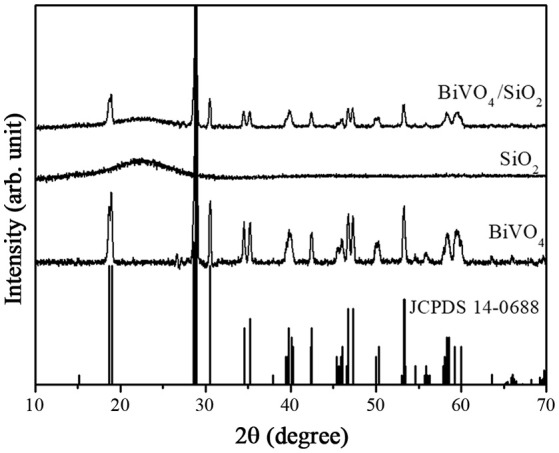
XRD patterns of as–prepared BiVO4, SiO2, and BiVO4/SiO2.